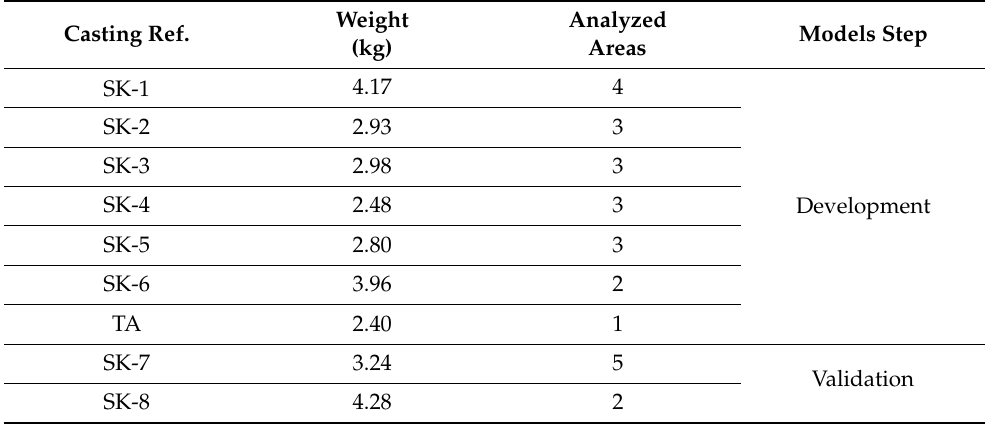
Table 1. Different industrial castings and number of sections used in each case. Casting